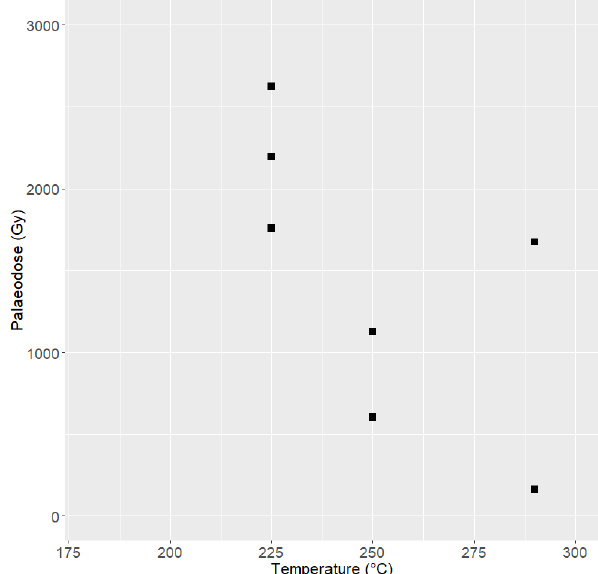
Figure B1. Preheat plateau for fine-grained sample L15 (A0111), showing substantial scatter between aliquots measured with the same preheat temperature, as well as between all